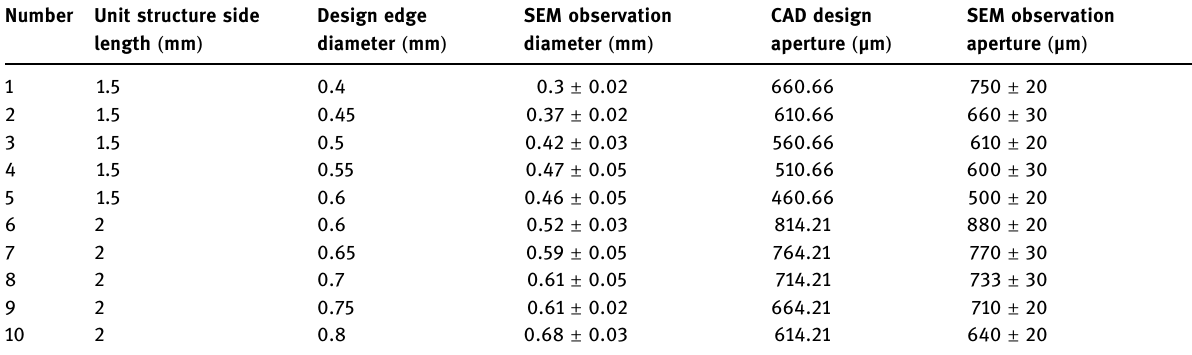
Table 5: The comparison of edge diameter and aperture between SEM observation and design size Number Unit structure side